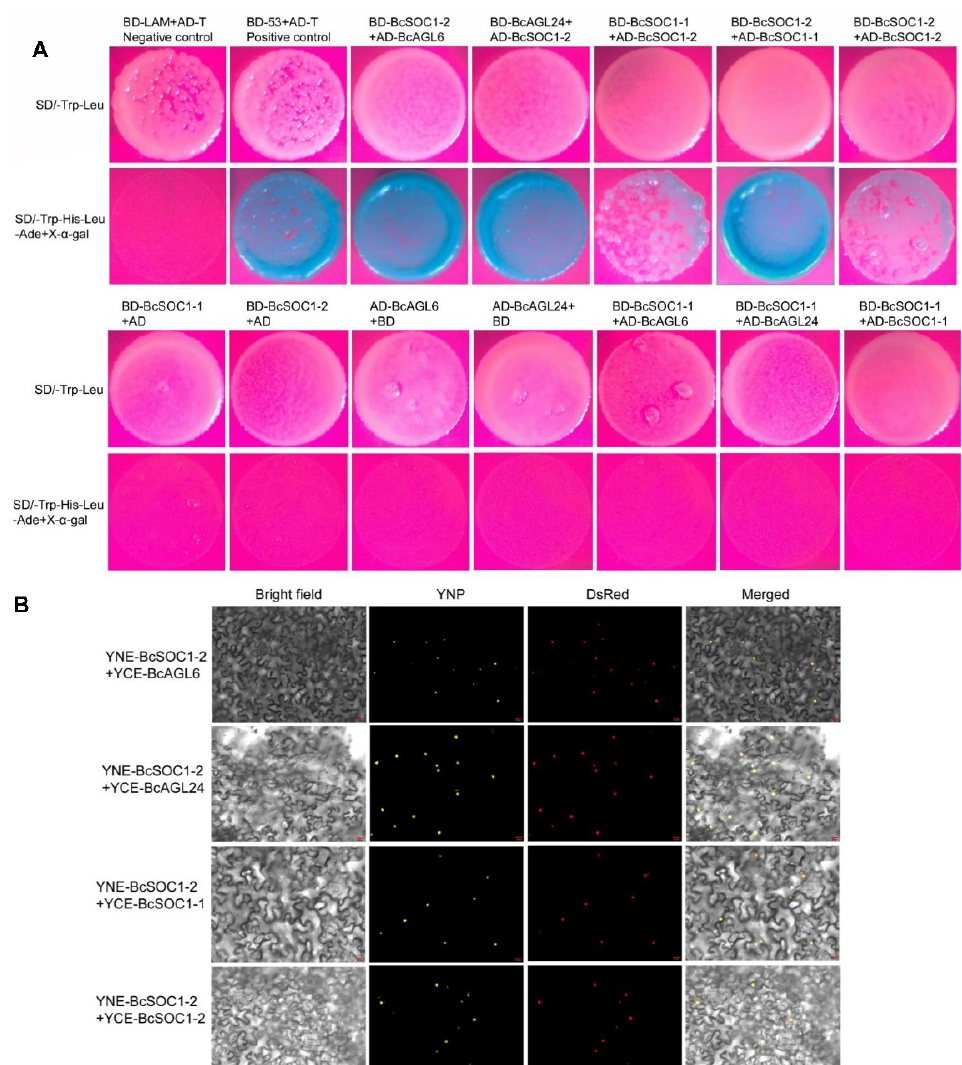
Figure 6. Yeast two ‐ hybrid and bimolecular fluorescence complementation assays to determine pro ‐ tein interactions. ( A ) Yeast two ‐ hybrid assay for protein–protein interactions between BcSOC1 and BcAGL6, BcAGL24, and BcSOC1. BD and AD represent empty pGBKT7 and pGADT7 vectors, respec ‐ tively. SD/ ‐ Trp ‐ Leu, the synthetic dextrose medium lacked tryptophan and leucine; the SD/ ‐ Trp ‐ His ‐ Leu ‐ Ade medium lacked tryptophan, histidine, leucine, and adenine. Positive bacteria were stained using X ‐α‐ Gal. ( B ) Bimolecular fluorescence complementation assay was used to detect the interac ‐ tions of BcSOC1 (fused with N ‐ terminal fragment of YFP) with BcAGL6, BcAGL24, and BcSOC1 ‐ 1 (fused with C ‐ terminal fragment of YFP). The nuclei were stained with DsRed. Bar = 50 μ